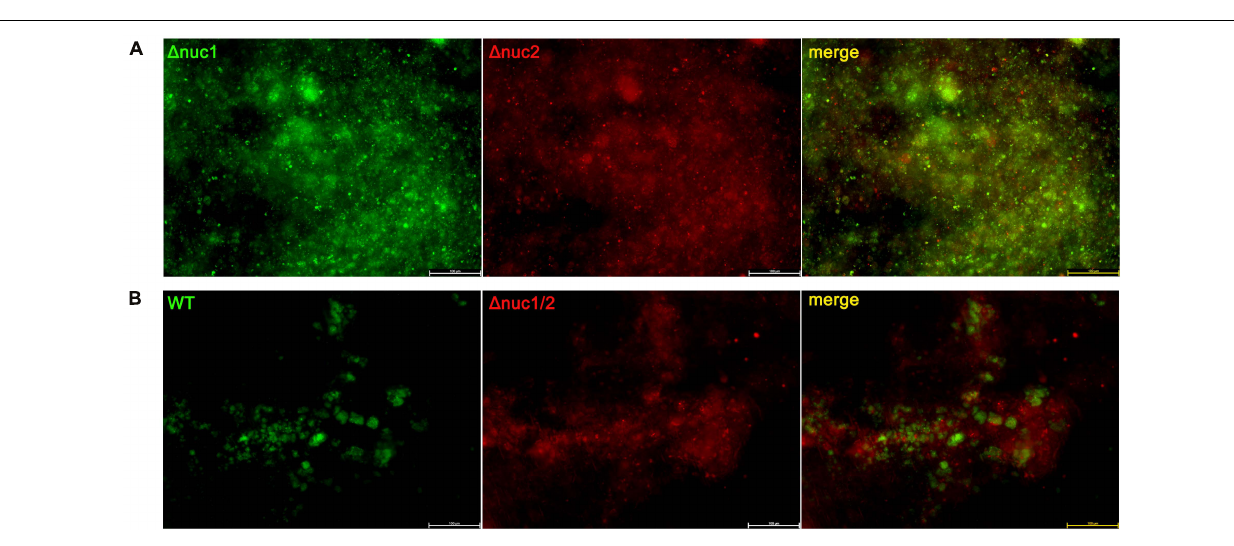
FIGURE 4 | Implant from a competition infection mouse model observed with a fluorescent microscope. Implants were harvested on the seventh day since infection and observed with a fluorescence microscope. (A) Implant from mice infected with a ∼ 1:1 mixture of (cid:49) nuc1 (green) and (cid:49) nuc2 (red). (B) Implant from mice infected with a ∼ 1:1 mixture of WT (green) and (cid:49) nuc1/2 (red). Scale bar = 100 µ m, n =